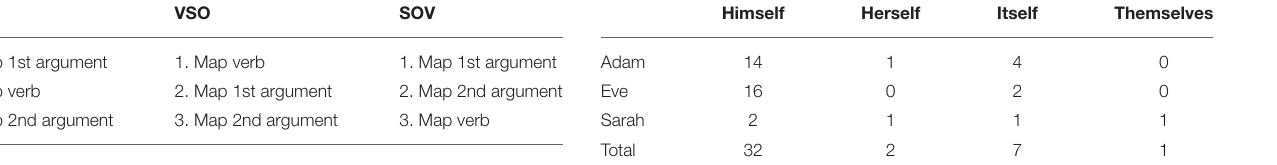
TABLE 2 | The order of activation of algorithms by word order type. SVO VSO SOV